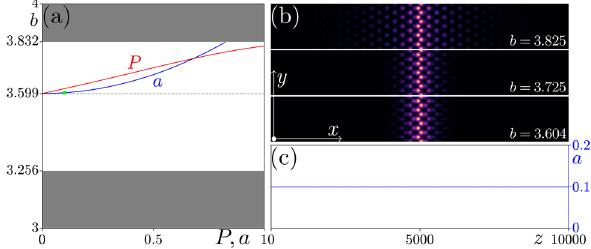
Figure 2: Nonlinear valley Hall edge state family. (a) Peak amplitude a (blue curve) and power P on one y -period (red curve) of the nonlinear valley Hall edge state family. The green dot represents the mode with b = 3.604, whose peak amplitude a ≈ 0.1. Thegrayregionsrepresentbulkbandsat k y = − 0.3K.Thedashedline shows the propagation constantof the linear edge state. (b) Pro fi les of selected nonlinear valley Hall edge states at different values of b . (c) The peak amplitude of the perturbed nonlinear edge state with b = 3.604 versus propagation distance z